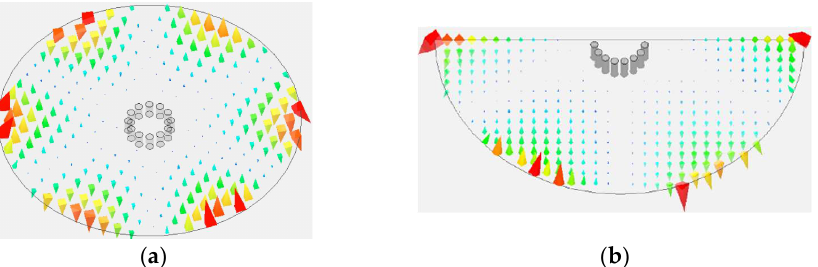
Figure 5. Electric field distributions of the TM310 mode of the two patch resonators. ( a ) Circular patch resonator; ( b ) semicircular patch resonator.